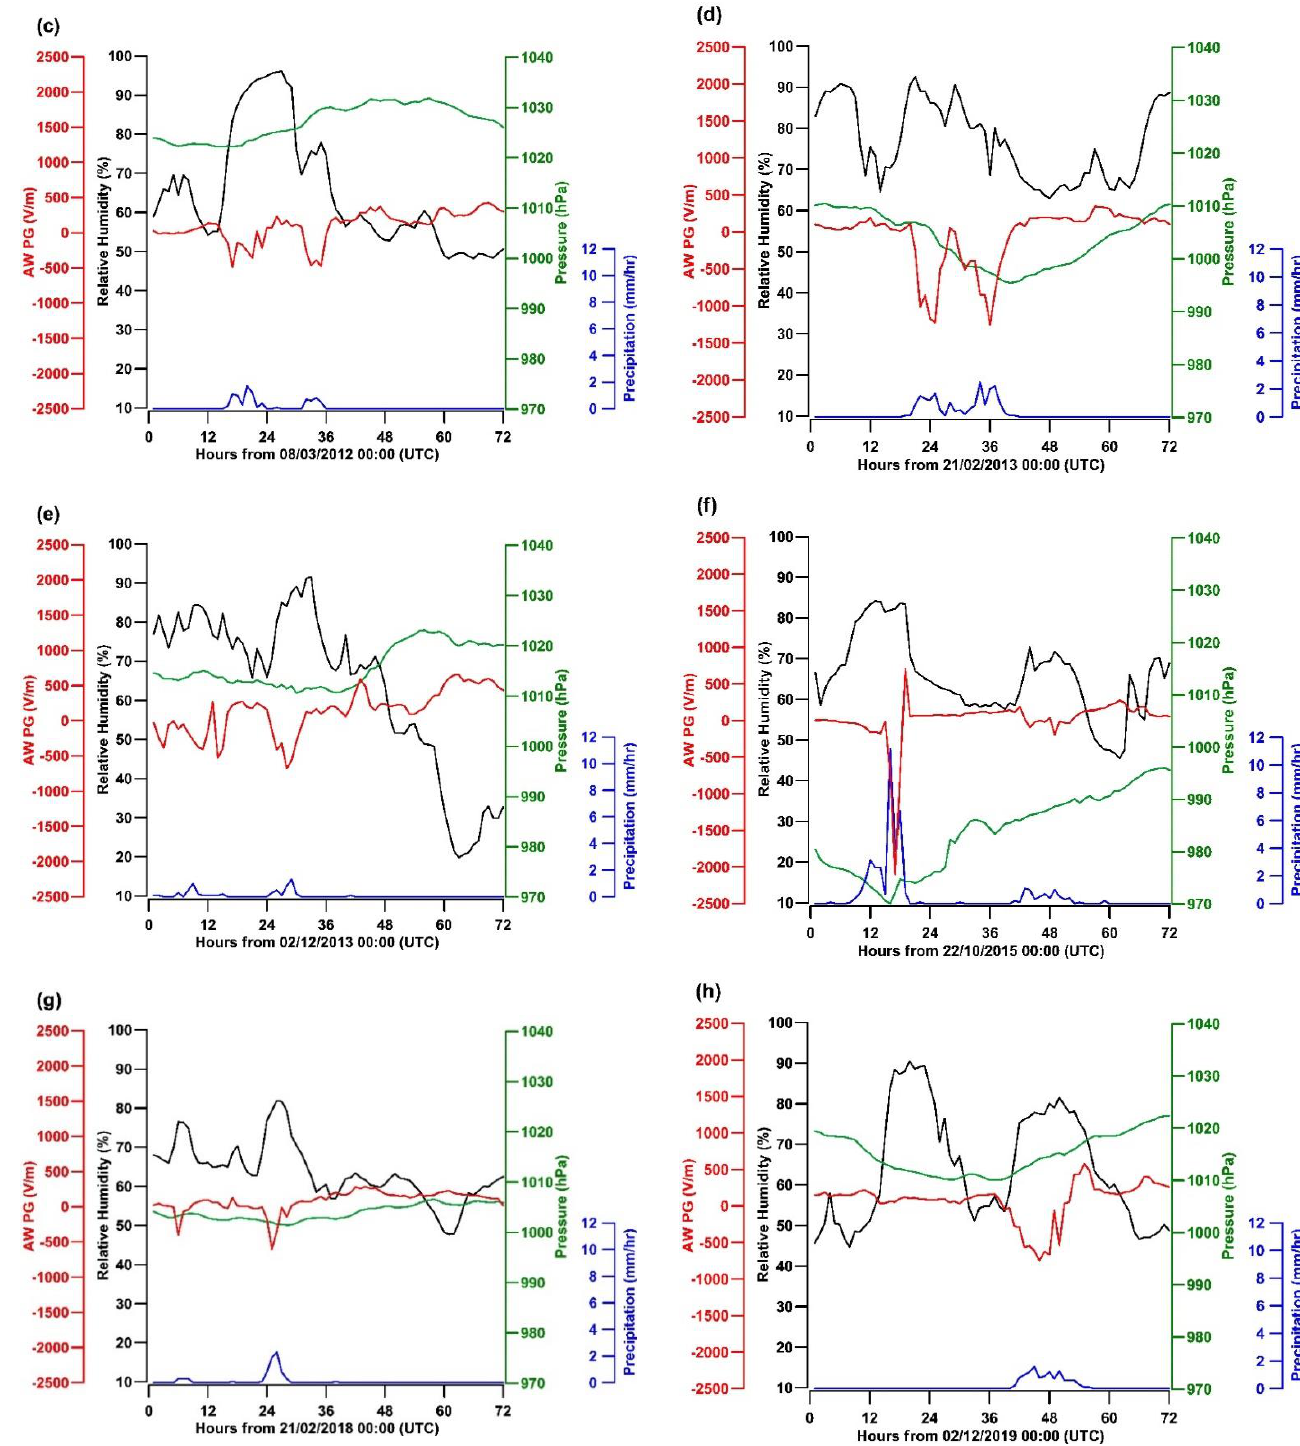
Figure 1. Hourly PG, RH, P and hourly precipitation rate of: ( a ) Rain event 21/01/2012; ( b ) Rain event 26-27/02/2012; ( c ) Rain event 08-09/03/2012; ( d ) Rain event 21-22/02/2013; ( e ) Rain event 02-03/12/2013; ( f ) Rain event 22/10/2015; ( g ) Rain event 21-22/02/2018; ( h ) Rain event 03-04/12/2019.